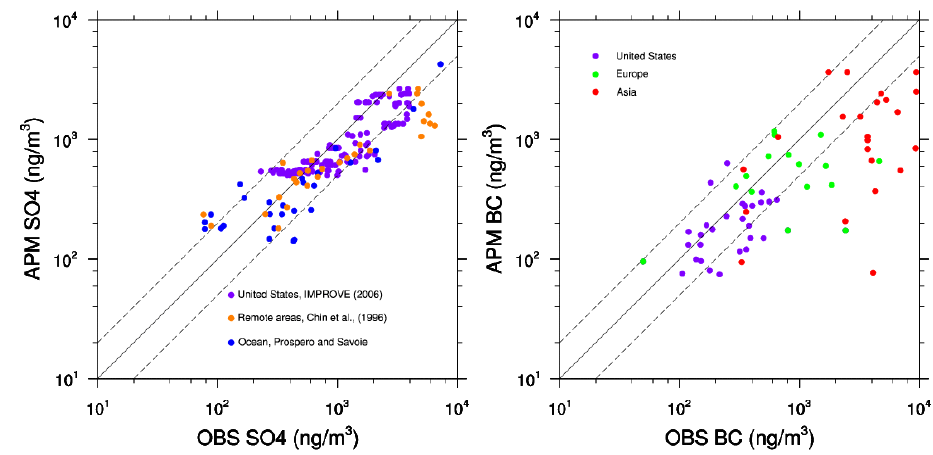
Fig. 2. Comparisons of GEOS-Chem-APM simulated surface sulfate and BC mass concentrations with observational data sets. The observed sulfate concentrations are taken from IMPROVE data set in 2006 (shown in the left), while BC concentrations obtained from Koch et al. (2009) (shown in the right). Three lines indicate 2:1, 1:1 and